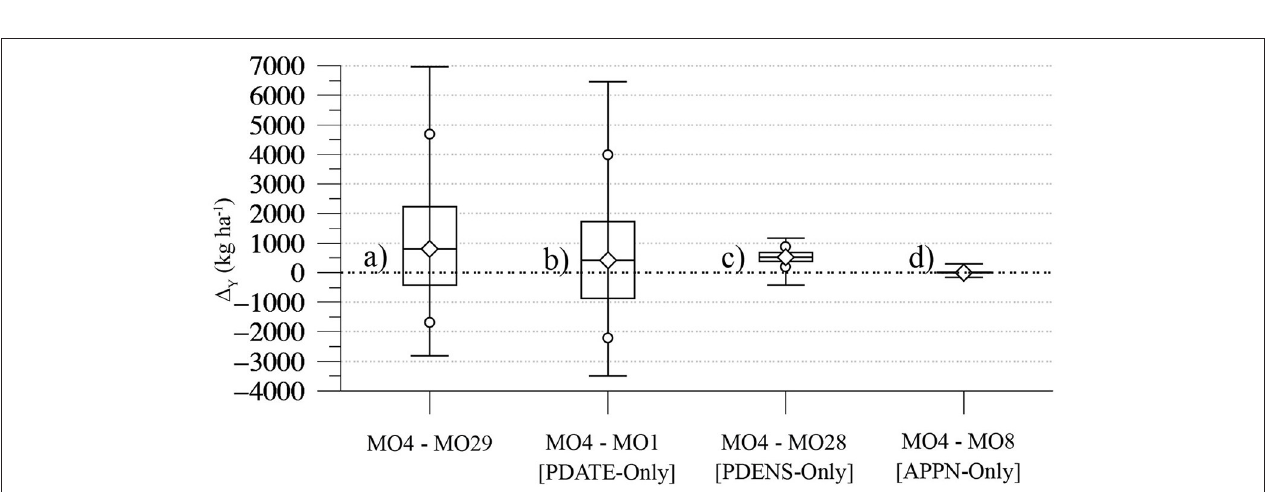
density (24.7 K plants ha − 1 ), and applied no nitrogen (MO 4).